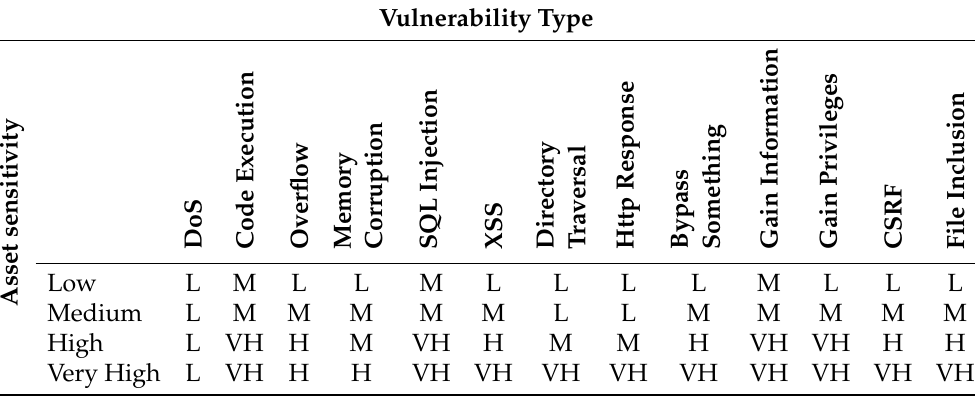
Table 3. Definition of the level of impact factor as a product ofthe type of a vulnerability and the sensitivity of an